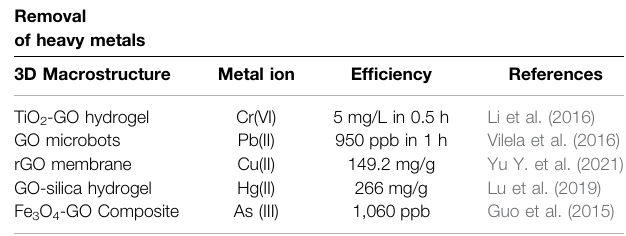
TABLE 1 | Applications of 3D graphene-based macrostructures in wastewater